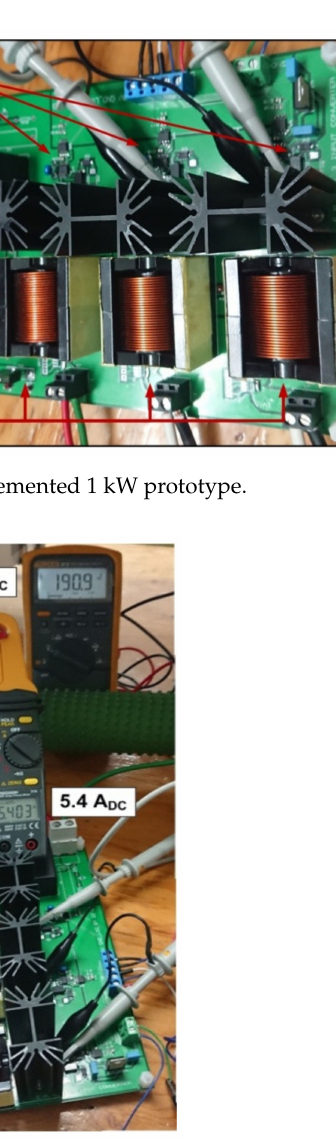
Figure 10. Implemented 1 kW prototype with voltage and current